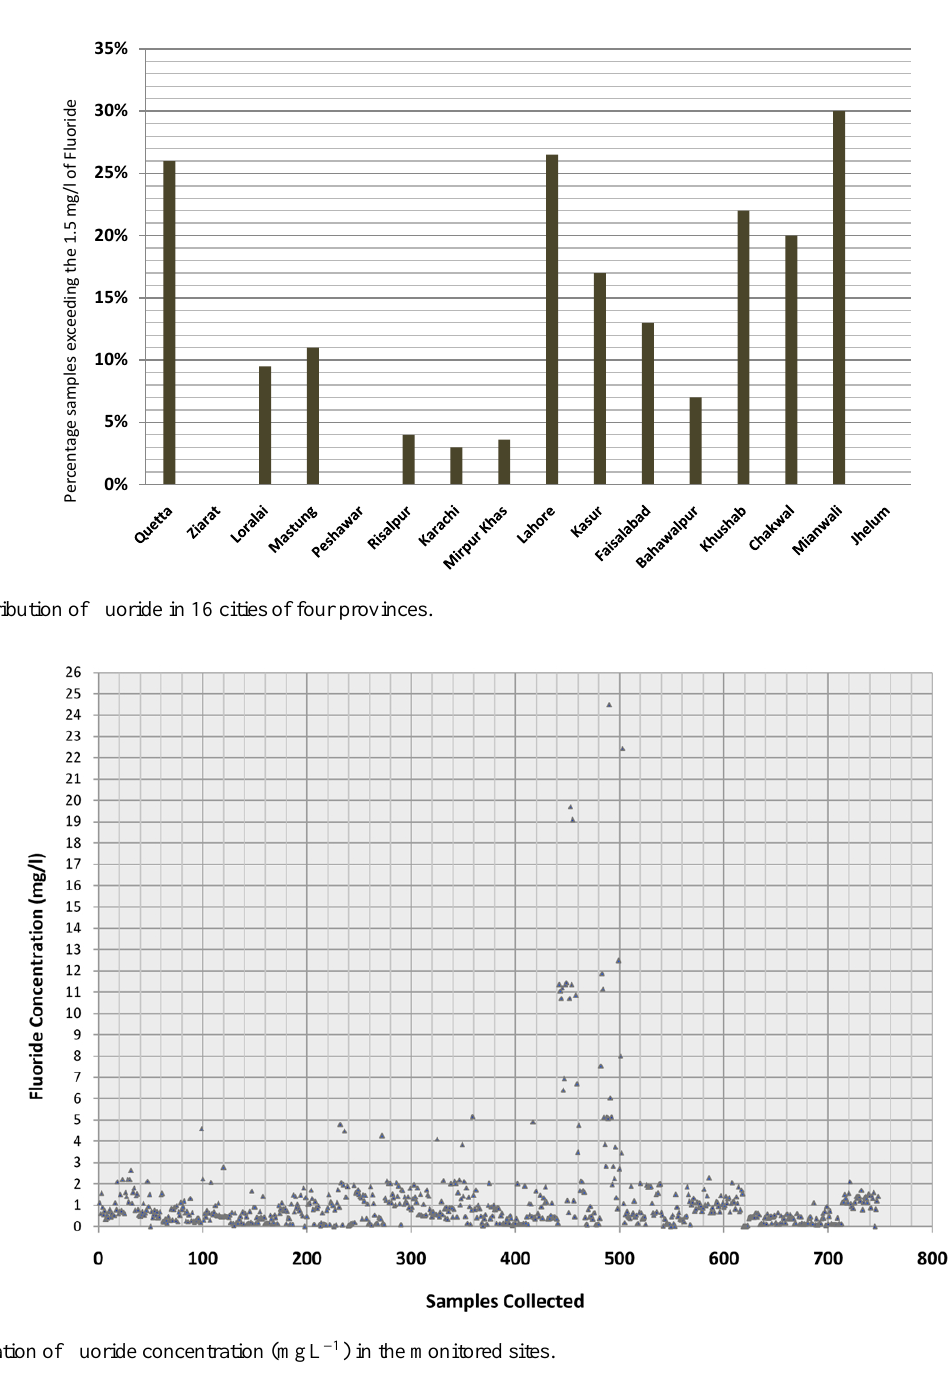
means and medians, we see that the means of fluoride are substantially greater than their medians (except for Jhelum city). The distributions of the data for these variables are highly skewed to the